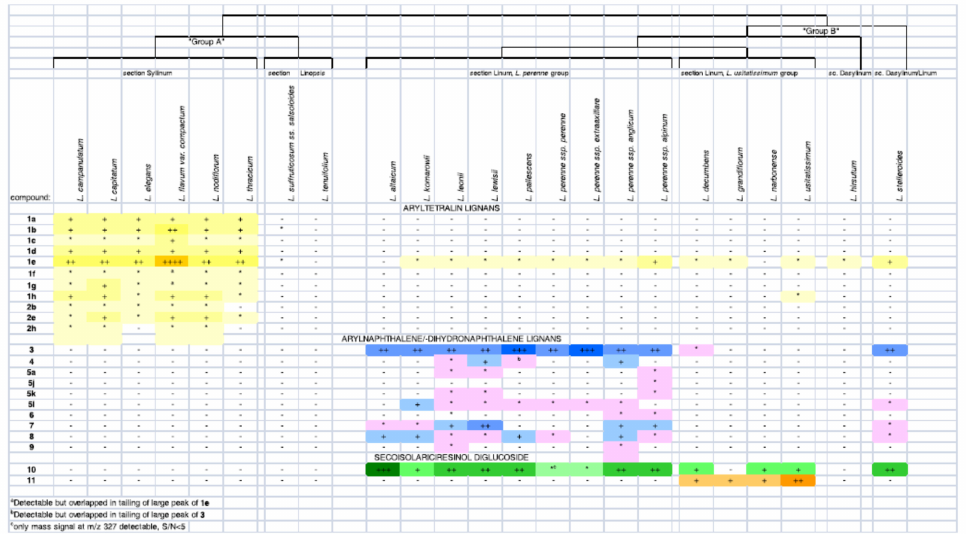
Figure 2. Distribution of lignans in seeds of Linum species. Taxa are ordered according to phyloge- netic relationship. Entry symbols represent approximate semi-quantitative estimates of concentration in mg/g seed material;.++++ >5, +++ >3<5, ++ >1<3, + >0.1<1, * <0.1; for details see experimental part. Reproduced with permission from the original article